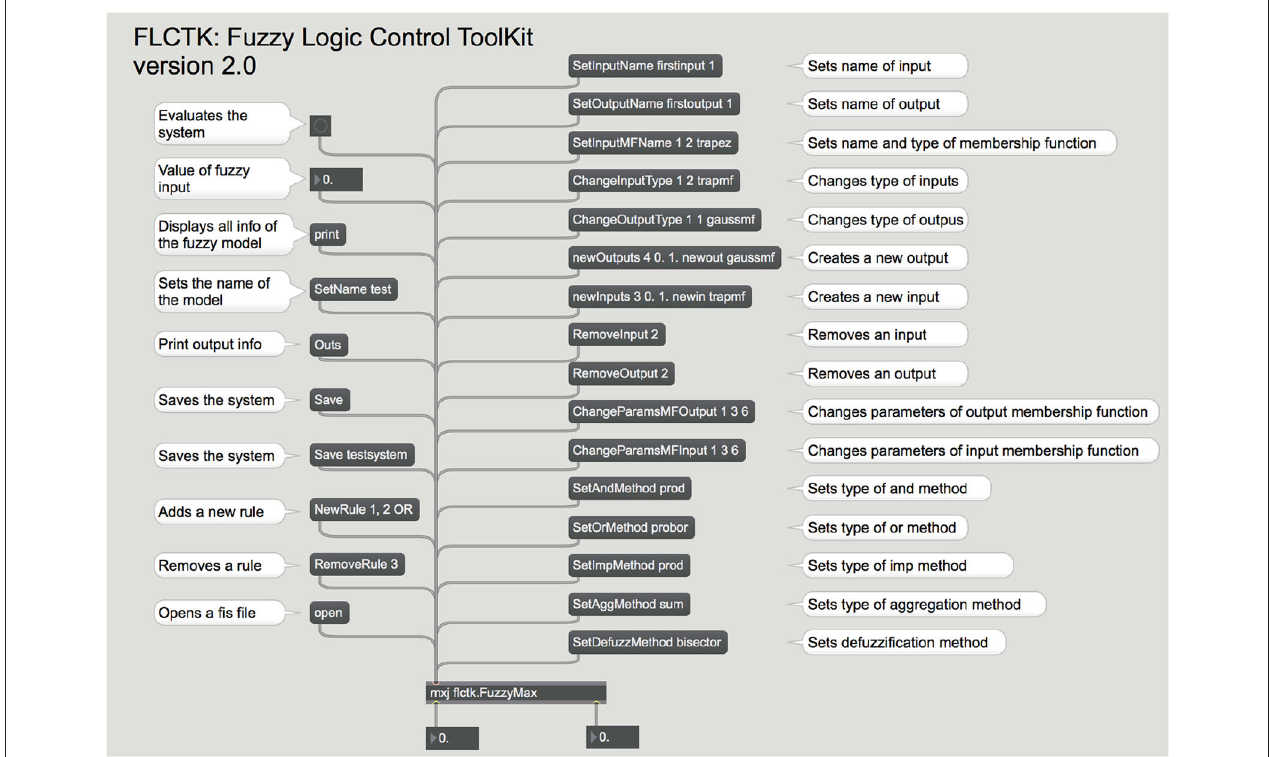
FIGURE 2 | Help screen of the Fuzzy Logic Control Toolkit ( FLCTK ) in the MaxMSP environment. Inputs, outputs and rules can be added and removed on-the-fly.